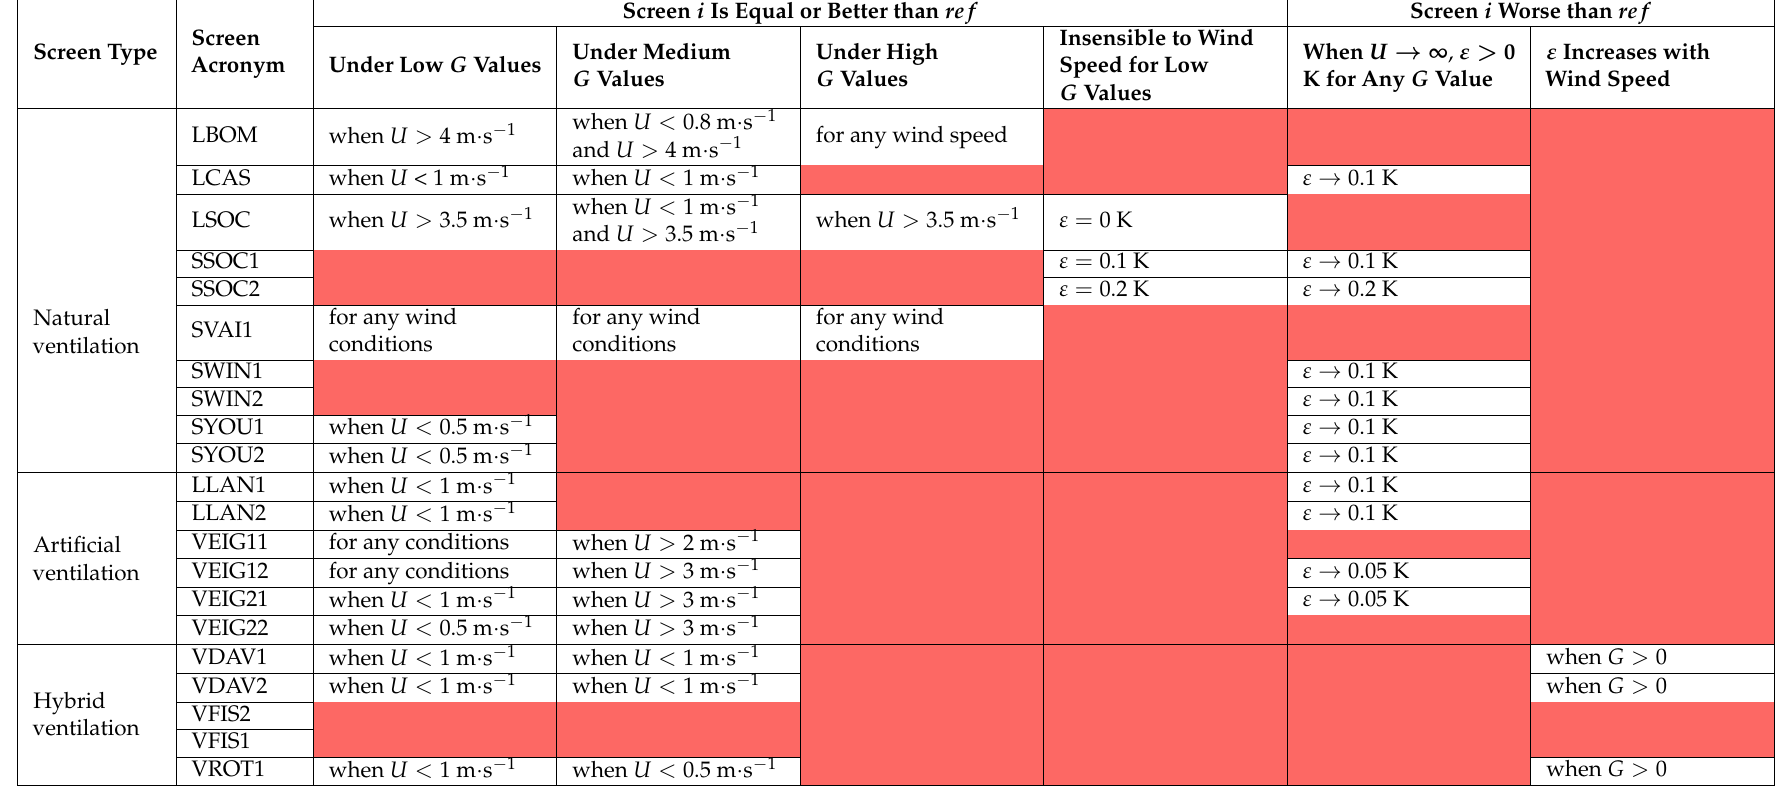
Table A2. Observed Screen Behavior for Different Wind Speed and Radiation